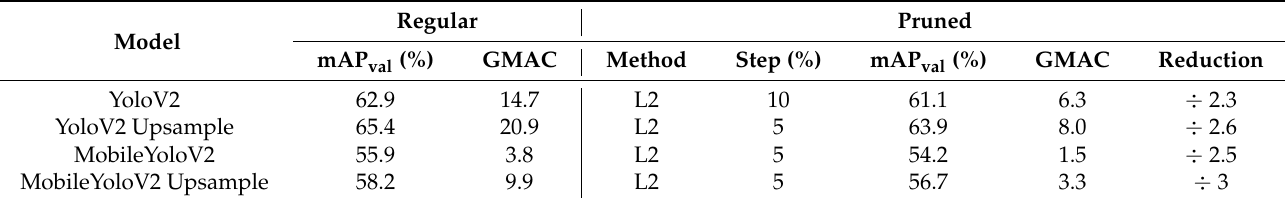
Figure 8. Accuracy (mAP) vs computational complexity (MAC) of the pruned models on the Pascal VOC validation data. Note the red horizontal and vertical lines, which indicate the values of the unpruned models. The Y-axis does not start at zero, in order to more clearly show the small differences in accuracy. Table 4. Accuracy (mAP) and complexity (GMAC) of the regular models, compared with the best pruned version of each model. Accuracy is computed on the Pascal VOC validation